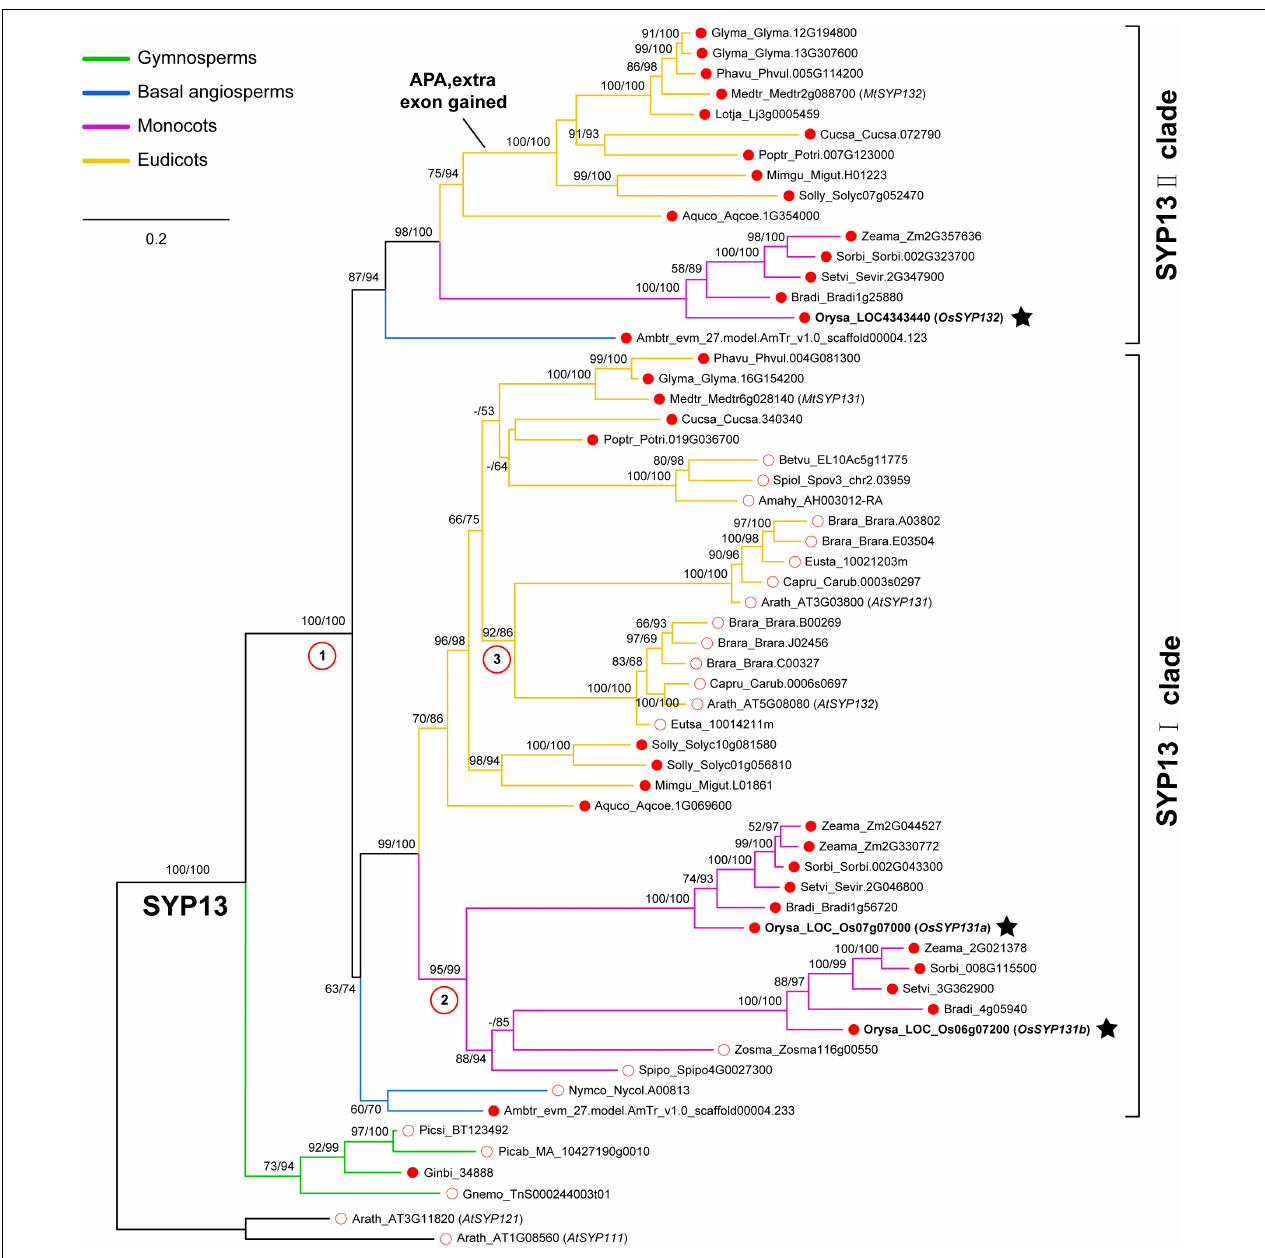
FIGURE 1 | Phylogenetic analyses of SYNTAXIN OF PLANTS 13 (SYP13) subfamily including 29 seed plants. The phylogeny was reconstructed using a maximum-likelihood method under the GTR + F + I + G4 model via IQ-TREE. Branch support values were examined by conducting the Shimodaira-Hasegawa approximate likelihood ratio test (SH-aLRT) and by performing 1,000 ultrafast bootstrap replicates. Two Arabidopsis thaliana SYP1 genes ( AtSYP111 and AtSYP121 ) were used as the outgroup. There were three duplication events in angiosperms marked by red circles with numbers. The ancestral SYP13 gene was first duplicated into two clades, SYP13I and SYP13II; then two independent duplications occurred in the common ancestor of Brassicaceae or that of monocots, respectively. Three rice SYP13 genes identified in this work were indicated by black stars. Red dot and red circle indicate AMS host plants and AMS non-host plants, respectively. The sequences from gymnosperms, basal angiosperm, monocots and eudicots were showed in different